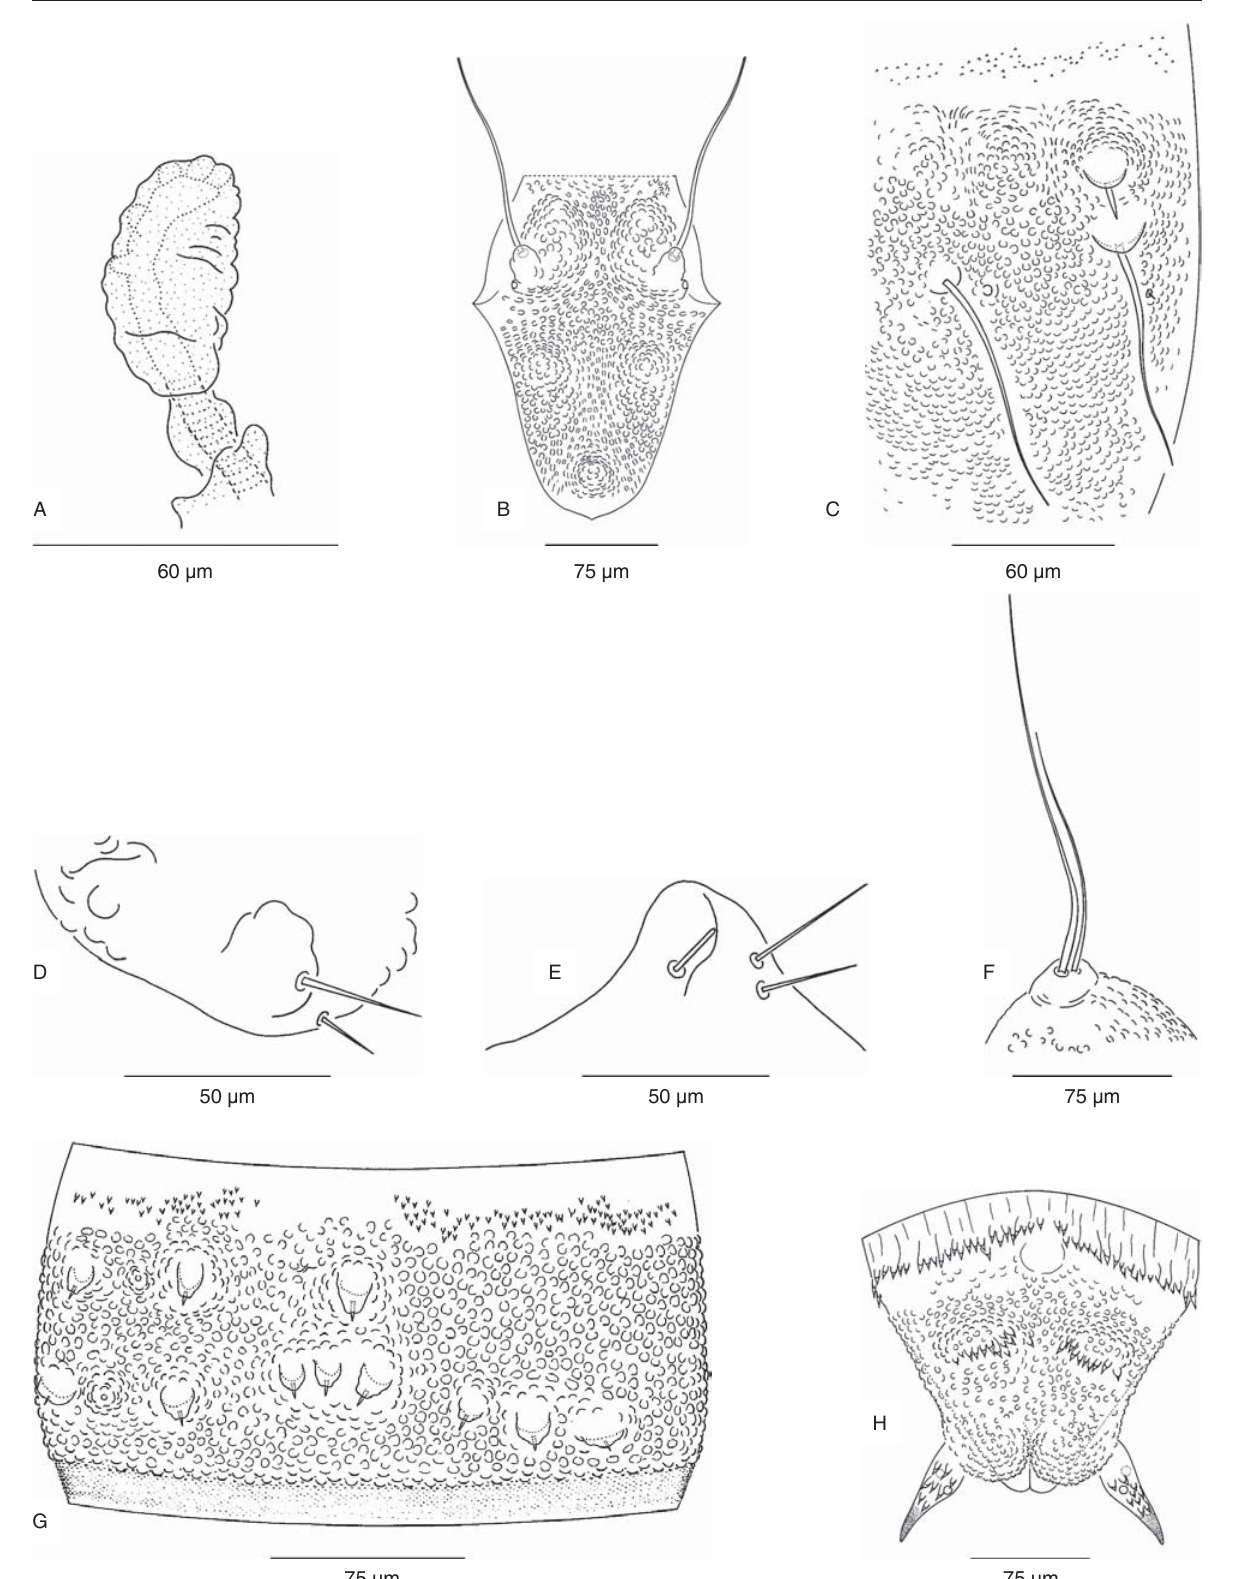
FIG. 5 The pupa of Culicoides sp. # 107: (A) prothoracic respiratory organ; (B) ♀ operculum; (C) thorax; (D) ventrolateral setae (vl); (E) dorsolateral tubercle (dl); (F) anterodorsal tubercle (ad); (G) fourth abdominal segment; (H) caudal